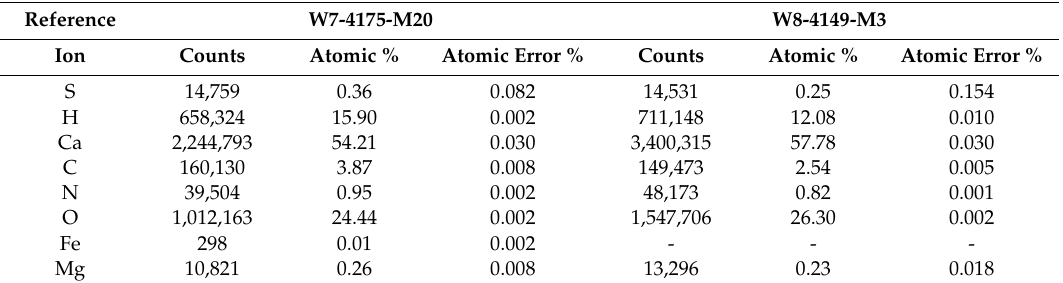
Table 3. Comparison of decomposed element composition for tips M20 (W7) and M3 (W8).